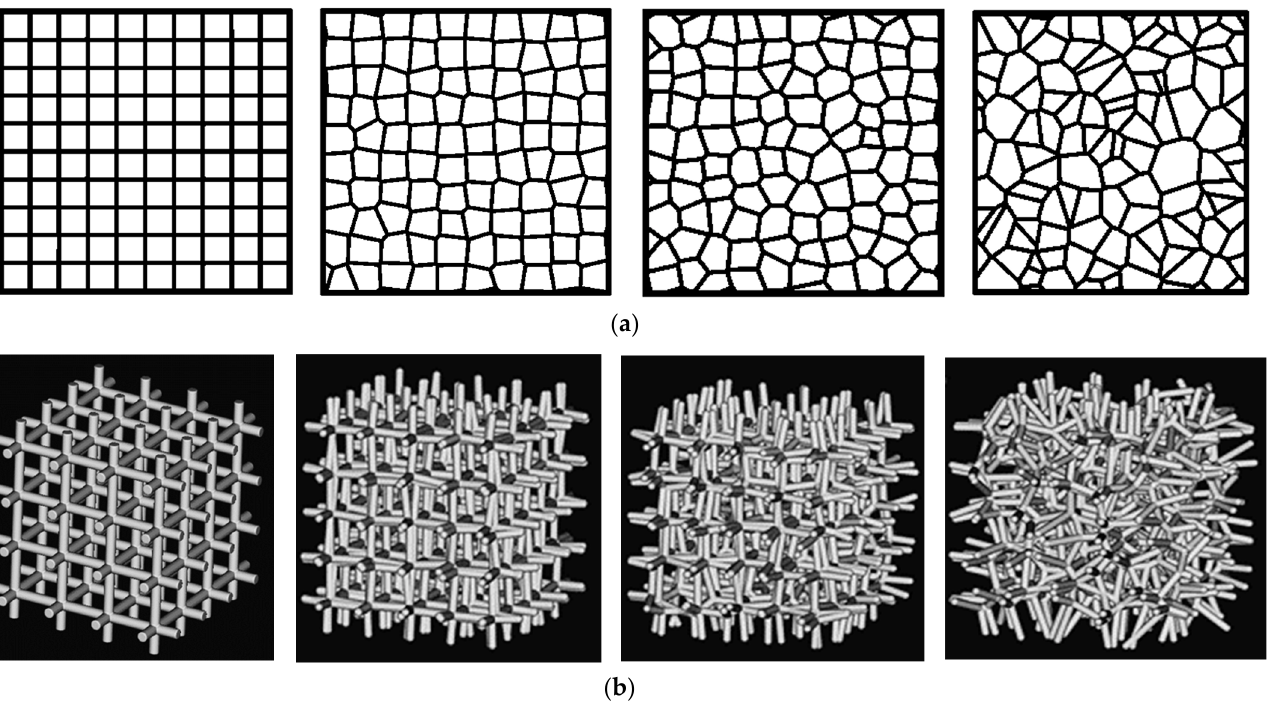
Figure 16. Increasing degree of aperiodicity applied to ( a ) a prismatic square grid honeycomb and ( b ) a cubic lattice.